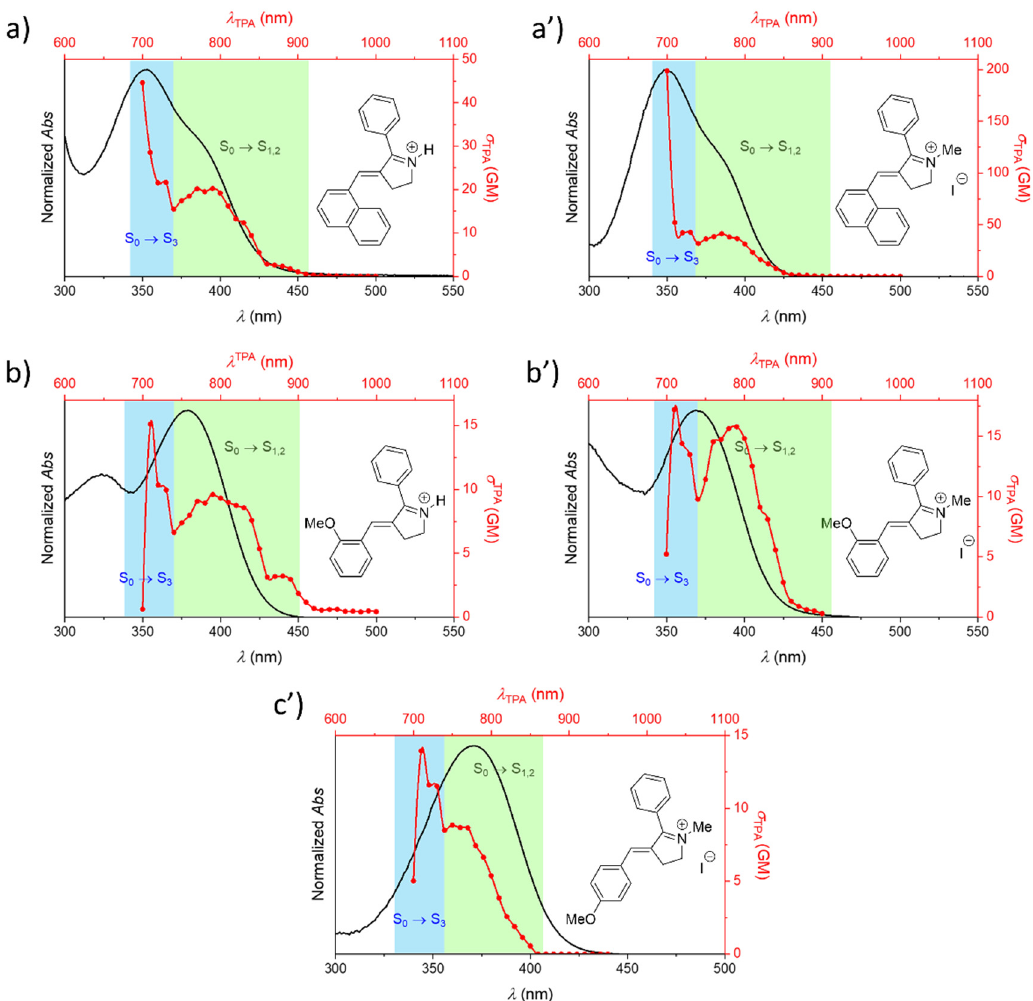
Figure 7. Comparison between experimental OPA (black lines) and two-photon absorption (TPA) spectra (red lines) of protonated Schiff base-like photoswitches and, when appropriate, also of their corresponding methylated analogues. The different studied derivatives are noted as ( a ) R 1 : -(1-Naphthyl), R 2 : Ph (protonated molecule); ( a’ ) R 1 : -(1-Naphthyl), R 2 : Ph (methylated molecule); ( b ) R 1 : -( o -OMe), R 2 : Ph (protonated molecule); ( b’ ) R 1 : -( o -OMe), R 2 : Ph (methylated molecule); and ( c’ ) R 1 : -( p -OMe), R 2 : Ph (methylated molecule). The main electronic transitions participating in the spectra are further indicated.